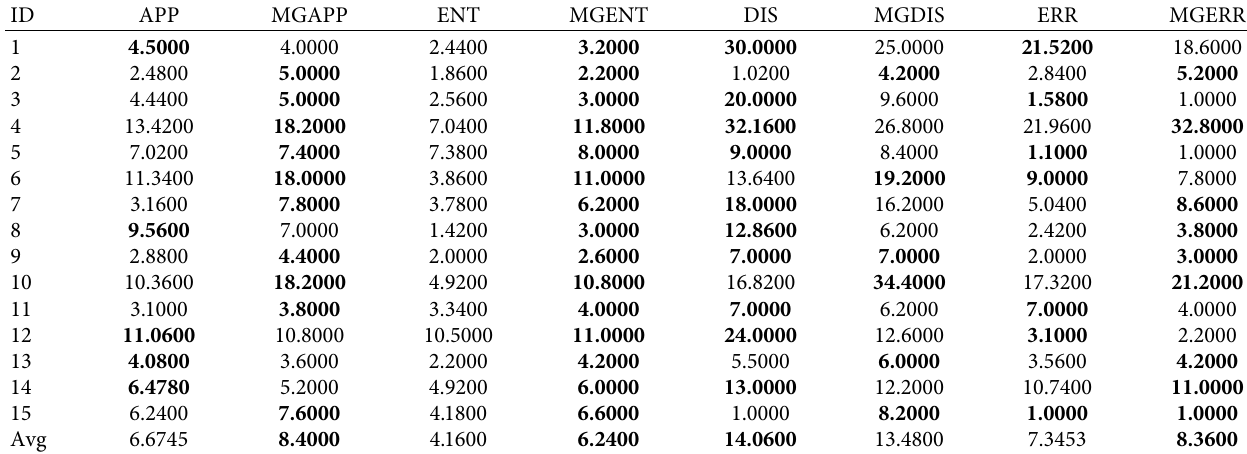
Table 3: Comparisons among the lengths of reducts (the greater values are in bold).